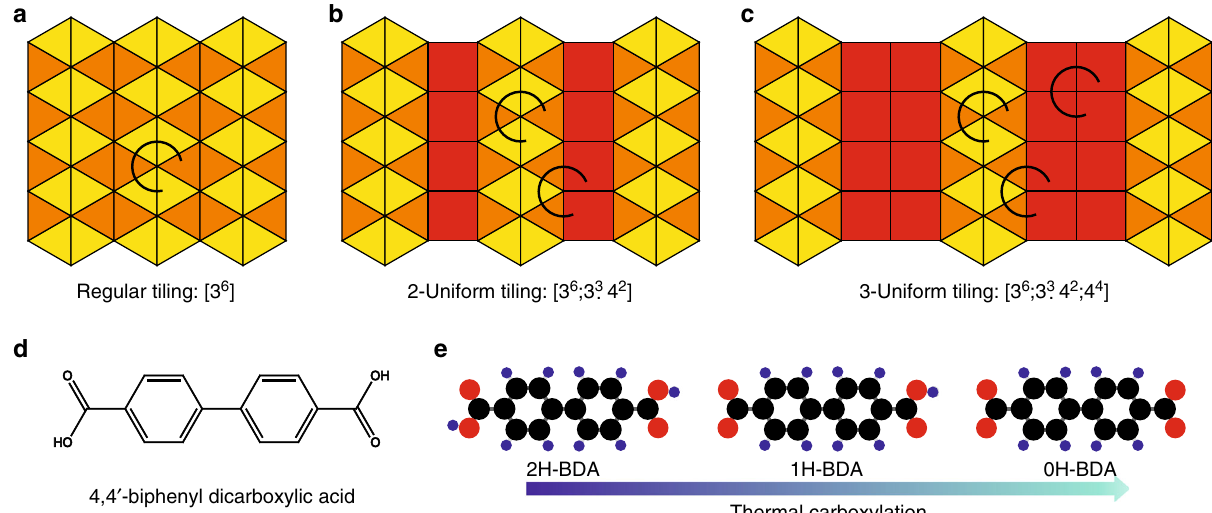
Fig. 1 Uniform tilings and employed molecular precursors. a – c Example of regular and k -uniform tilings of Euclidean plane comprising two type of tiles: triangles and squares. The distinct types of vertices are marked by arcs. There is one type of vertex in regular tiling ( a ), two types in 2-uniform ( b ), and three types in 3-uniform tiling ( c ), respectively. d Chemical structure of 4,4 ’ biphenyl dicarboxylic acid (BDA) and (e) models of BDA with distinct level of